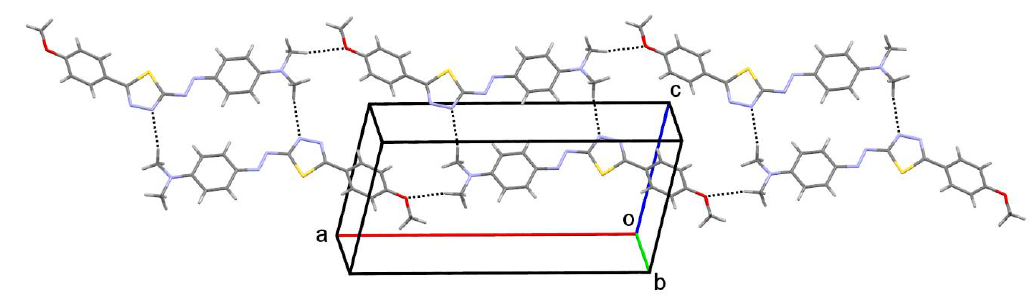
Figure 4. Part of molecular packing showing a supramolecular ribbon extending along the Figure 4. crystallographic axis. Hydrogen bonds indicated by dotted lines. crystallographic axis. Hydrogen bonds indicated by dotted